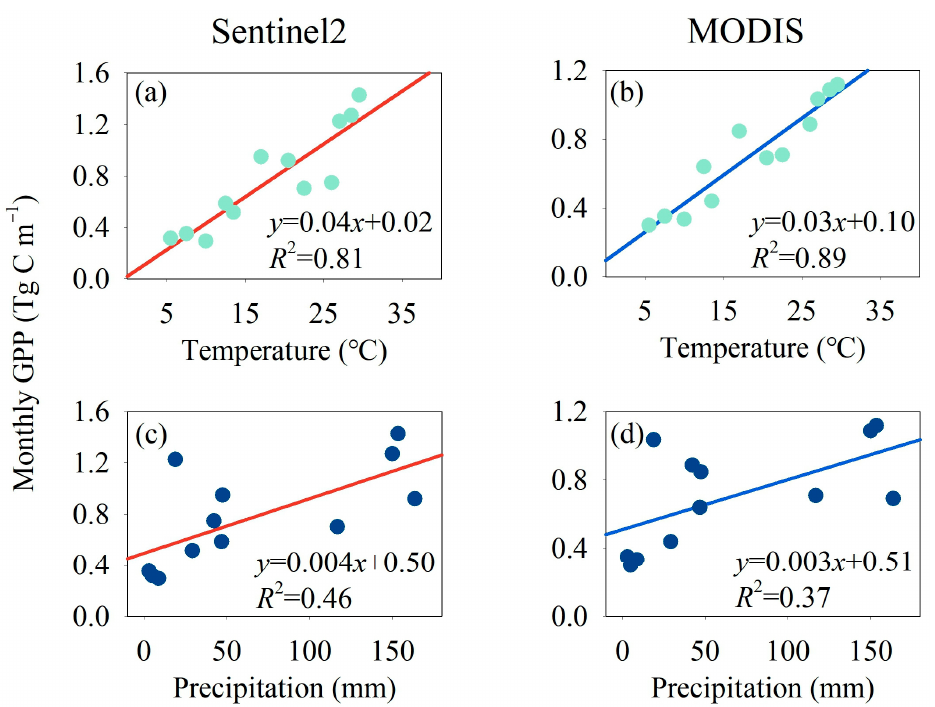
Figure 6. The relationship between the estimated GPP and climate factors. ( a ) and ( b ) are the correlations between temperature and monthly GPP for Sentinel2 and MODIS, respectively. ( c ) and ( d ) are the correlations between precipitation and monthly GPP for Sentinel2 and MODIS, respectively.